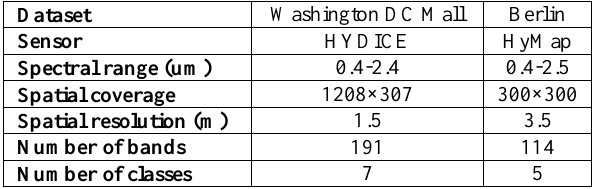
Table 1. The main characteristics of the datasets used.